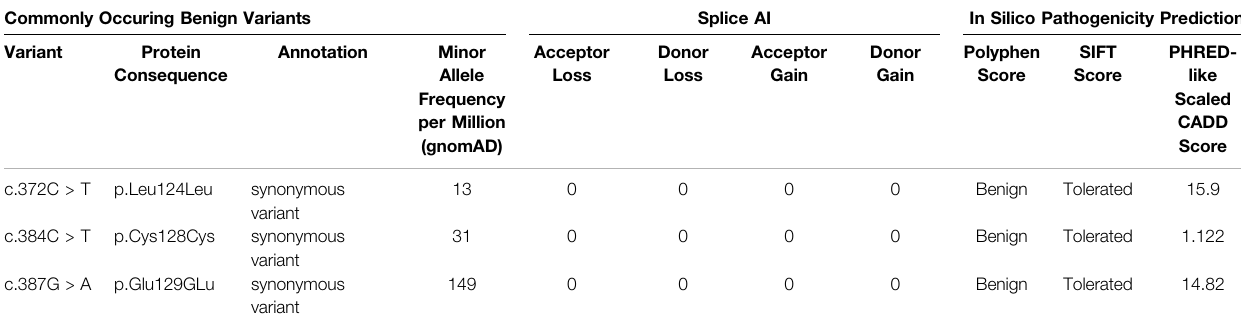
Frontiers in Genetics |